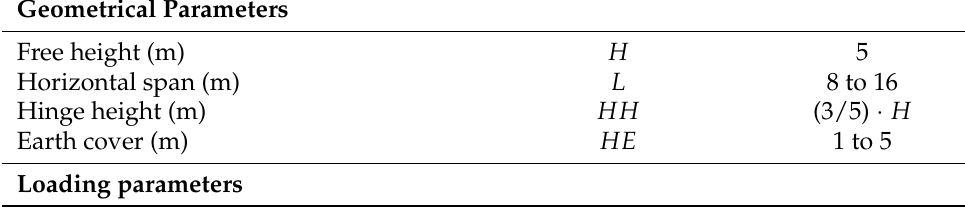
Table 3. Main parameters considered in the RMHF